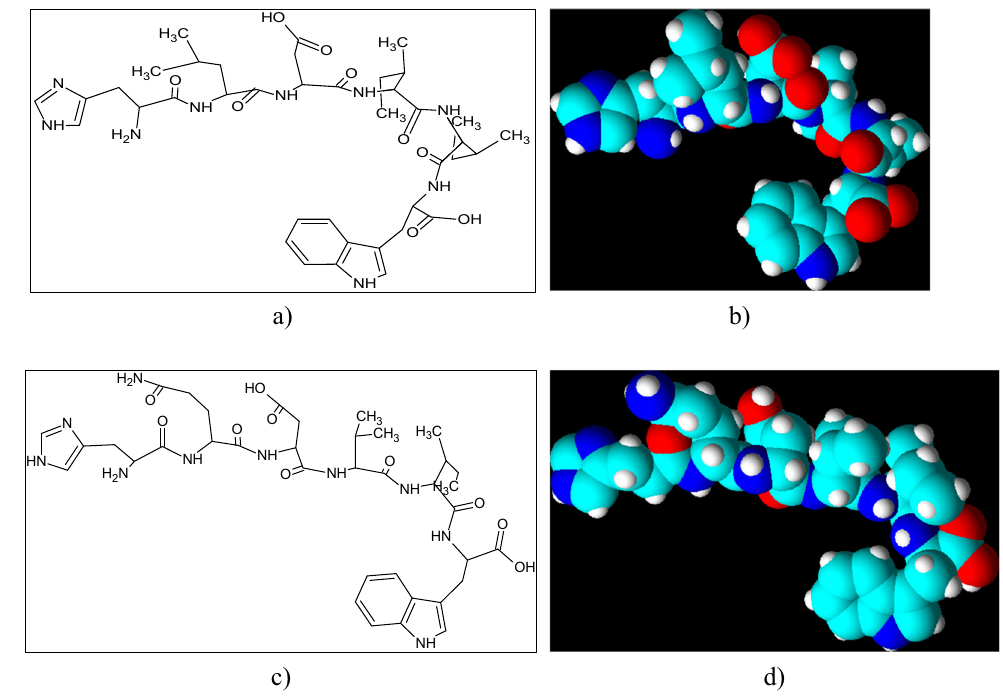
Figure 11: Tail chain structures ( AA 16 – 21 ) ; ( a ) ETs tail chain structure ( without explicit hydrogens shown ) ; ( b ) ETs chain structure space - fi lling model; ( c ) SRT - 6b chain structure ( without explicit hydrogen atoms shown ) ; ( d ) SRT - 6b chain structure space - fi lling model.